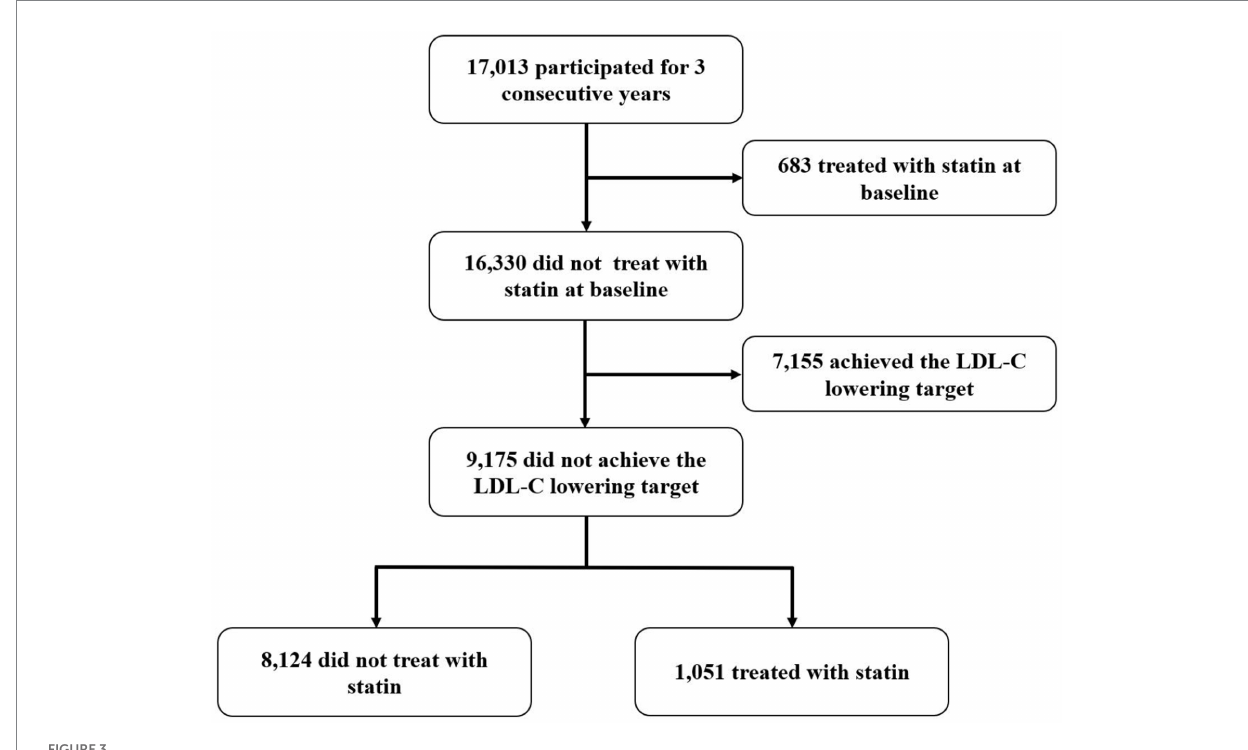
FIGURE 3 Overview of the participants with three consecutive years